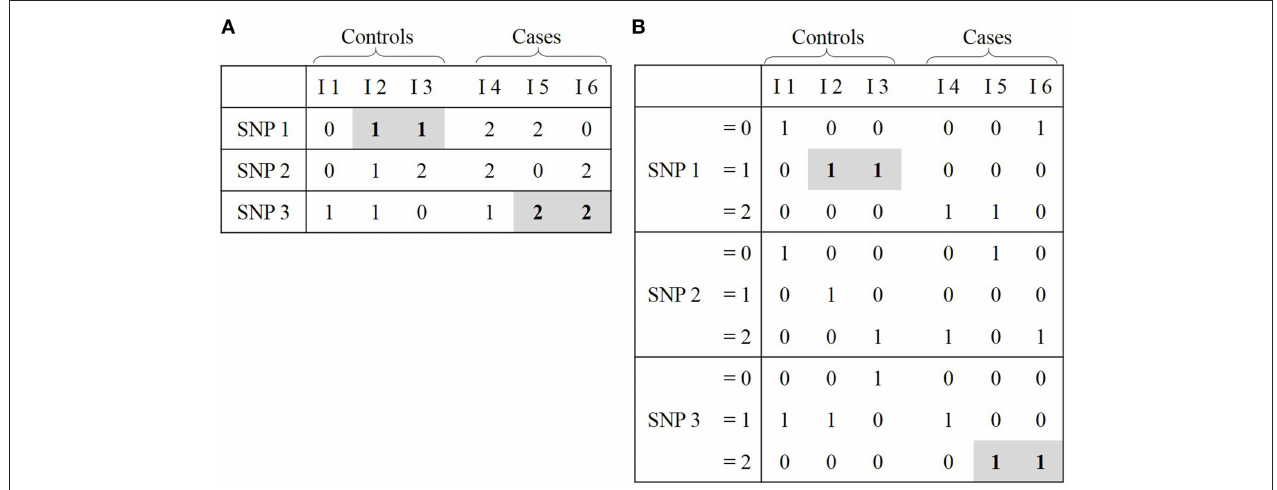
FIGURE 3 | Representations of GWAS data. (A) Classical representation: cell (i, j) corresponds to status of SNP i for individual j. (B) Binary representation: cell (i, j) corresponds to the true (1) or false (0) assertion that a SNP i has a specific value (0, 1, or 2) for individual j. For ease of comprehension, the link between these two representions is highlighted in